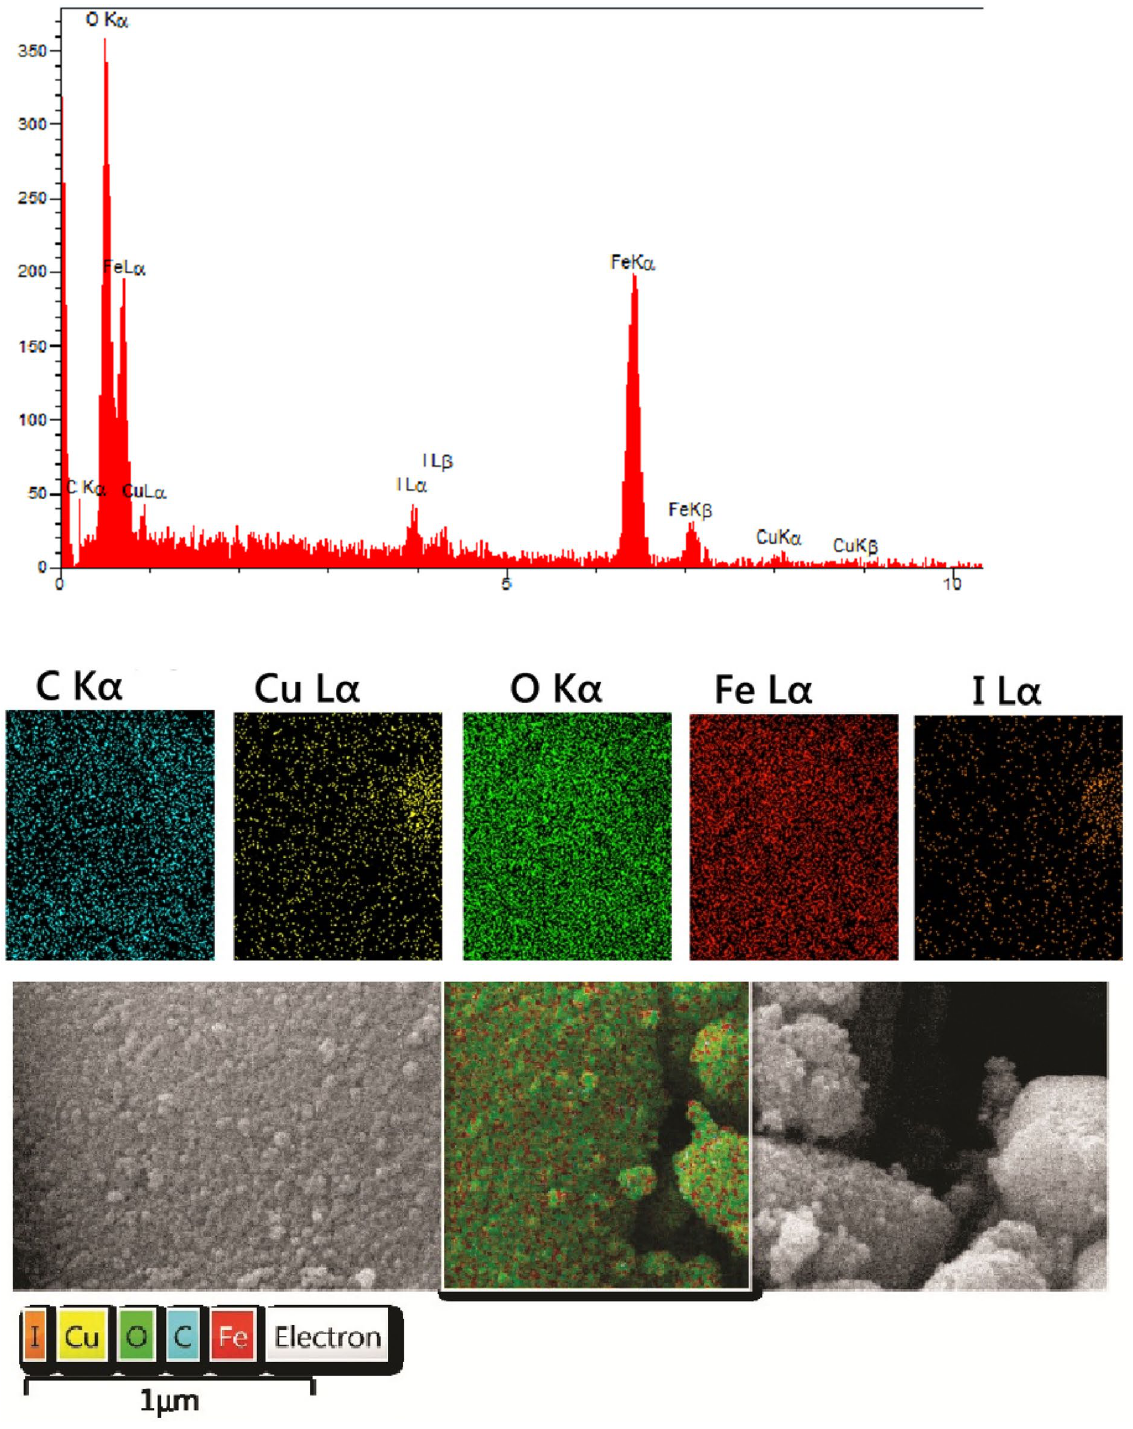
Figure 6. ( A ) Energy-dispersive X-ray spectroscopy (EDX), ( B ) Elemental mapping analysis of Fe 3 O 4 @CQD@